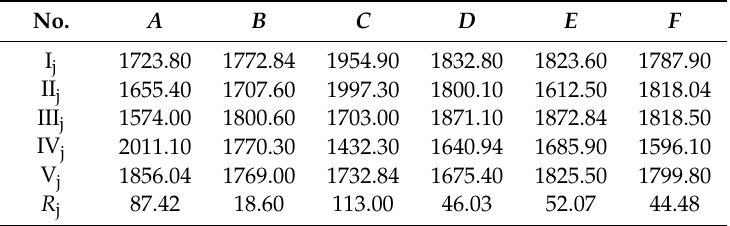
Table 6. Microhardness Range Analysis Data Sheet (Microhardness /